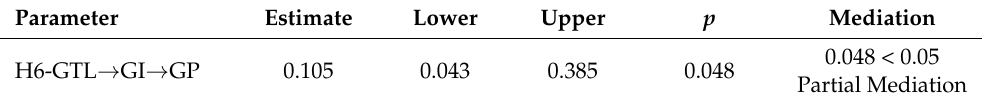
Table 4. The mediation effect of GI (developed by the authors using SPSS and AMOS software). Parameter